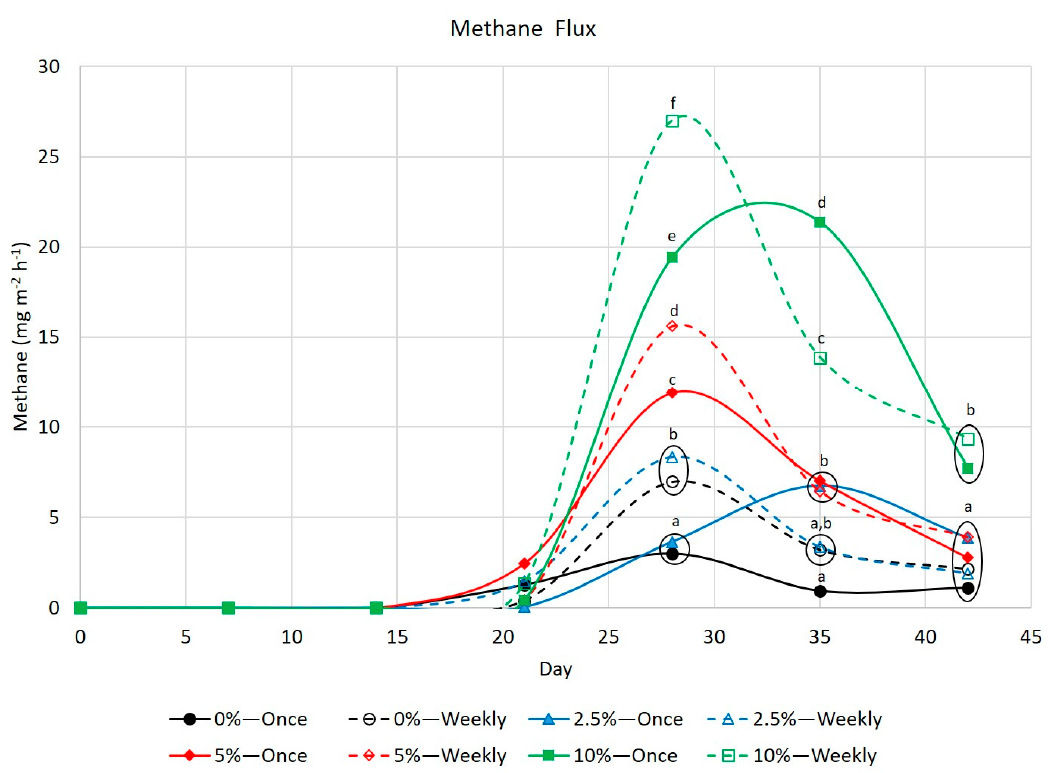
Figure 3. Average methane flux (mg m − 2 h − 1 ) for weekly measurements taken over 42 days for bedded packs treated with 0, 2.5, 5, and 10% alum, either in one dose or in weekly doses. Alum × Dose × Day interaction p < 0.01, Pooled standard error of the mean = 0.76. Clusters with different letters indicate significant differences p < 0.05 .